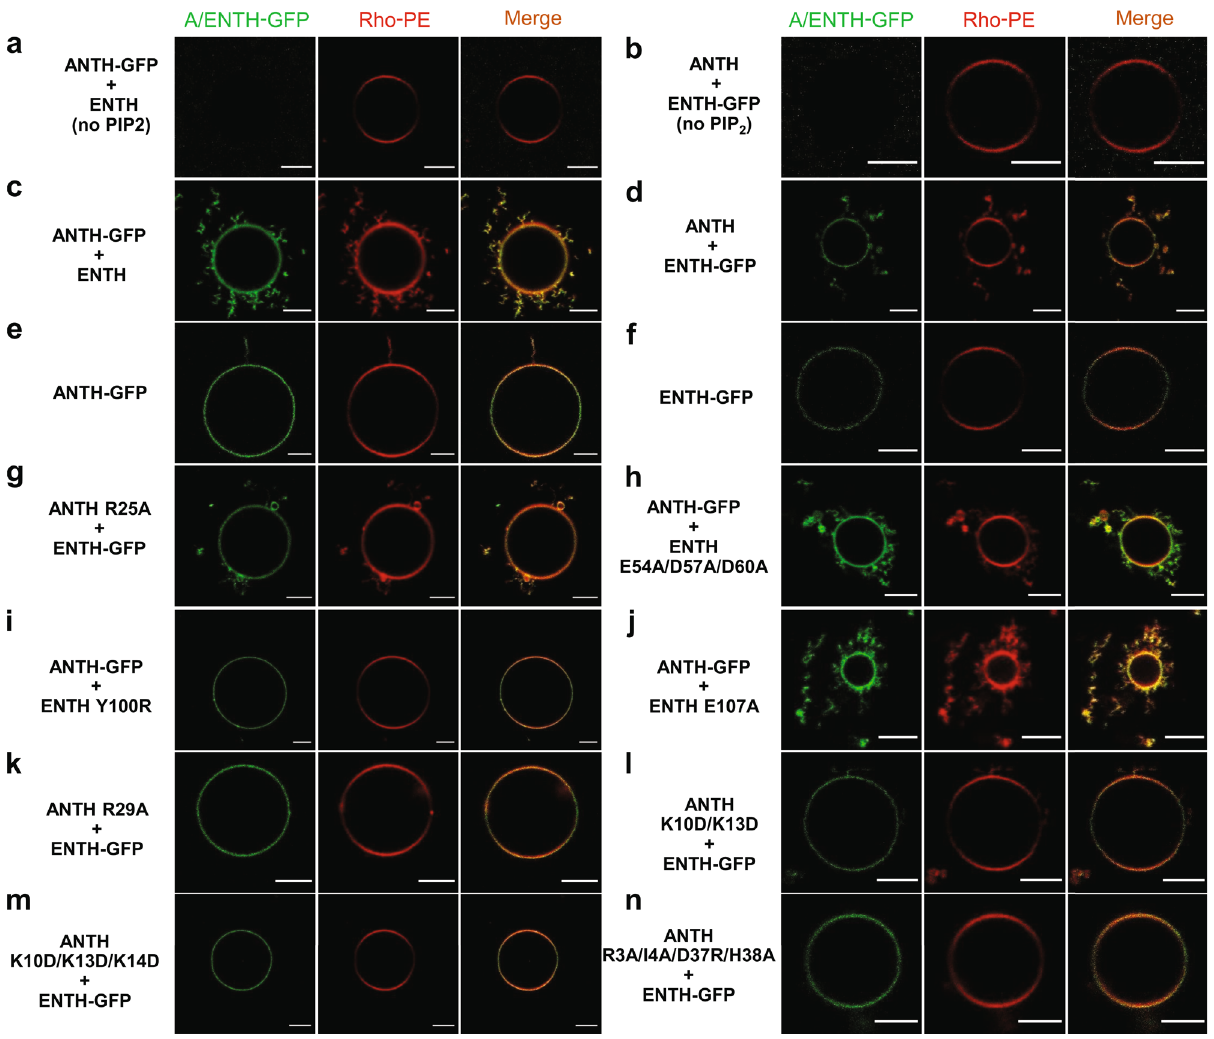
Fig. 6 Effect of AENTH tetramer and mutants on GUVs by fl uorescence microscopy. a , b ANTH-GFP and ENTH-GFP do not bind GUVs without PIP 2 . c , d ANTH-GFP or ENTH-GFP mixed with ENTH or ANTH, respectively, caused membrane deformation as seen by the numerous membrane protrusions around GUVs. e , f ANTH-GFP or ENTH-GFP did not cause a remodeling effect on the GUV membrane. g – n ANTH and ENTH mutants mixed with ENTH- GFP and ANTH-GFP, respectively, showed different membrane deformation capabilities. Each experiment was repeated independently 3 times with similar results. All scale bars are 5 µ